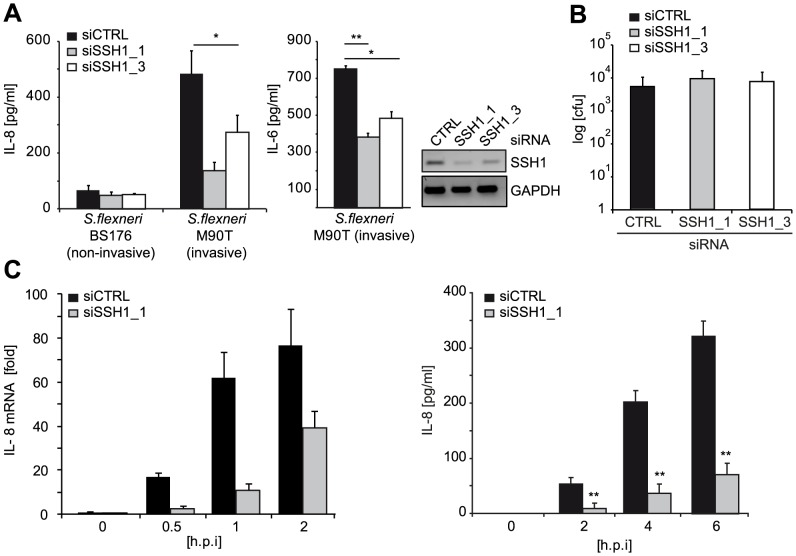
SSH1 is involved in early Shigella-induced pro-inflammatory responses.(A) HeLa cells were transfected with CTRL or SSH1 siRNAs and incubated for 72 h and infected with Shigella flexneri M90T or BS176 (MOI = 10). IL-8 and IL-6 (right panel) secretion was determined 6 h post infection by ELISA. Values are mean + S.D. (n = 2), representative of three independent experiments. Knock-down efficiency was determined by RT-PCR (right panel). (B) Intracellular bacteria were counted after gentamycin treatment of the cells treated as in (A) 2 h post infection. (C) HeLa cells treated for 72 h with siCTRL (filled bars) or siSSH1_1 (gray bars) were analyzed at the indicated time-points after infection with S. flexneri M90T afaE. Quantitative PCR of cDNA normalized to GAPDH expression and IL-8 concentration in the supernatant (right panel), mean + S.D. (n = 3) are shown. Significance was calculated by student's t-test (unpaired, two-tailed) *p<0.05, **p<0.005 (see also Figure S5).